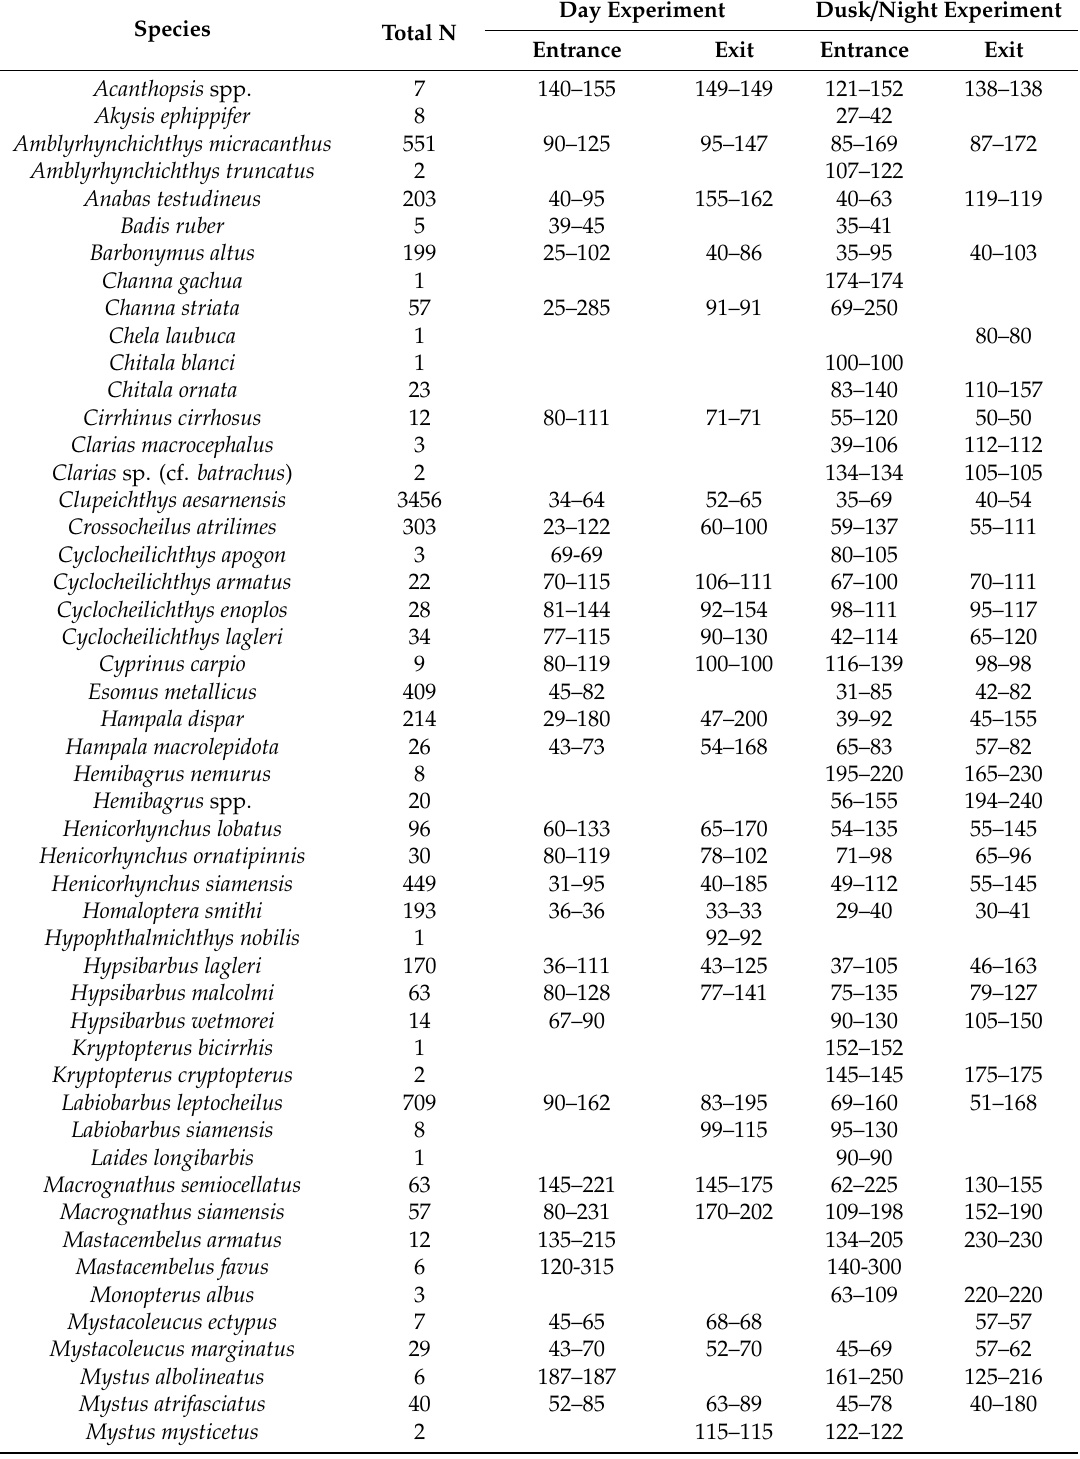
Table A1. Summary of fish species caught at the cone fishway entrance and exit, and their respective length ranges for the day and dusk / night experiments (mm